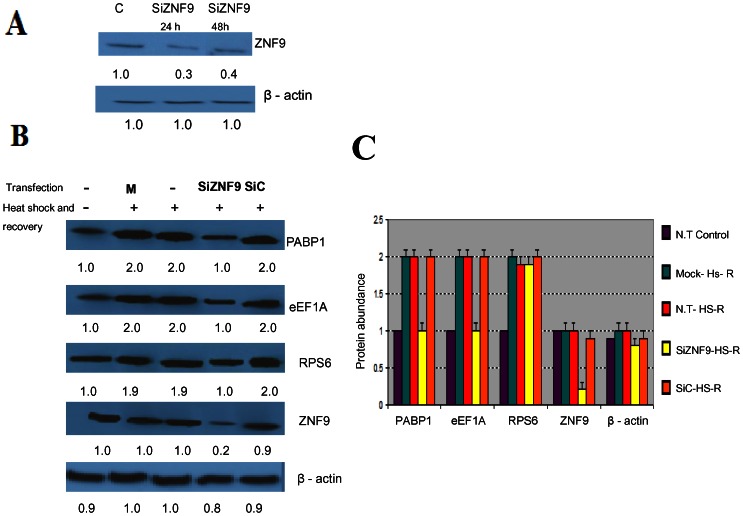
ZNF9 knock down with siRNA.A) Exponentially growing HeLa cells were transfected with ZNF9 siRNA as described in materials and methods for 24 and 48 hours. Samples of total cell lysate from non-transfected (C) and transfected cells following 24 and 48 hours of transfection (SiZNF9) were analyzed for the abundance of ZNF9 and β-actin (loading control) by western blotting. B) Cells at 40% confluency were either kept at 37°C as controls or were heat shocked for 3 hours at 44°C and allowed to recover for 4 hours at 37°C before being transfected with either no RNA (M), ZNF9 siRNA or a validated negative control siRNA. Cells were incubated at 37°C in a CO2 incubator in the presence of the transfection complex for 24 hours and following lysis samples were processed for further analyses by SDS-PAGE and western blotting as described in materials and methods. C) The abundance of specific polypeptides was determined by scanning the images, and normalizing the values using the β -actin levels as loading controls as described in materials and methods.